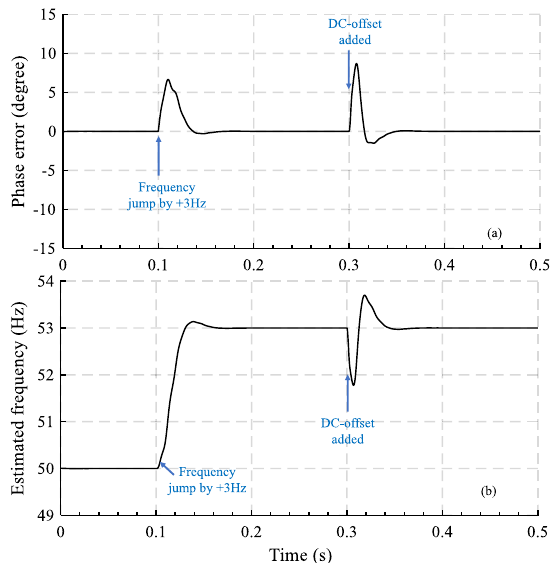
Fig. 6 Results of case study 2 grid conditions. a Estimated phase error and b estimated grid